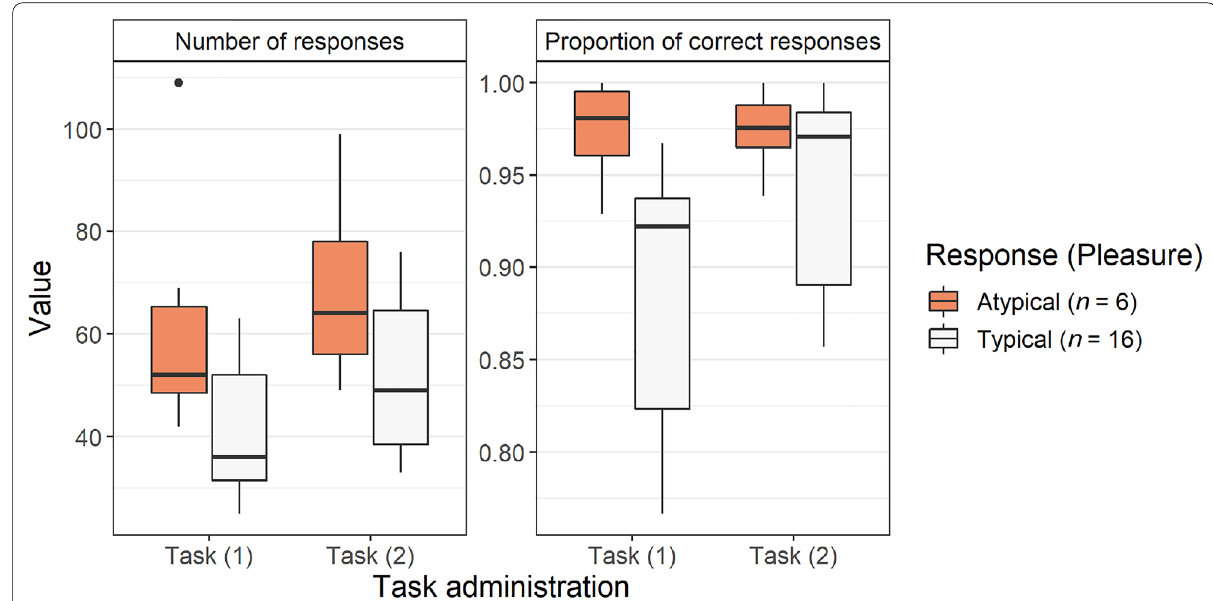
Fig. 10 MAT results on the first and second task administration, split by participants with atypical and typical pleasure score